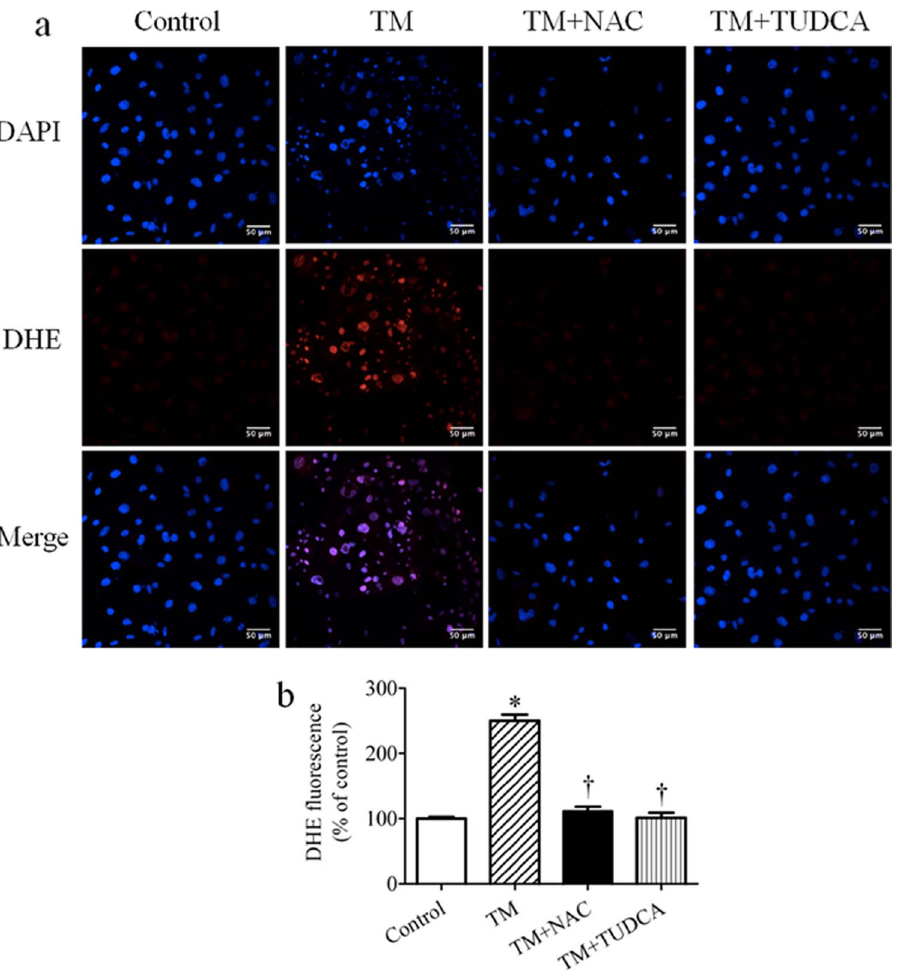
Figure 6. The effect of NAC and TUDCA on tunicamycin (TM)-induced ROS production in cultured myotubes. Representative confocal microscopy pictures (a) and spectrophotometric quantification (n=6) (b) of intracellular ROS production in C2C12 myotubes treated with tunicamycin in presence of 10 mmol/l NAC or 1 mmol/l TUDCA for 24 hours. ROS detection dye DHE is shown as red, the nucleus is stained with DAPI (blue), with purple suggests colocalization. Scale bars, 50 m